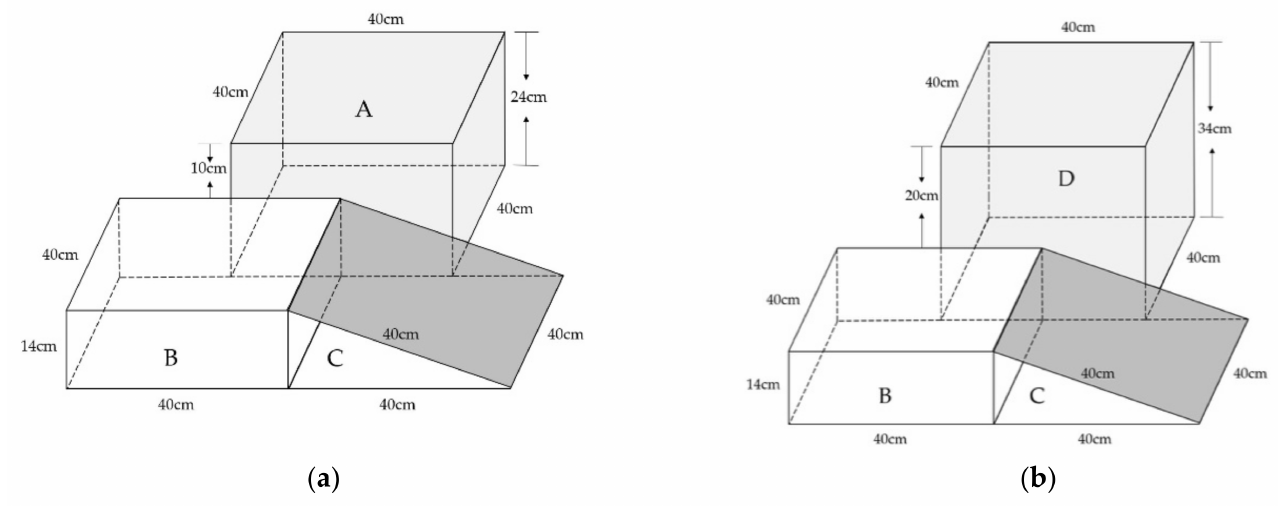
Figure 1. The two different heights of AIDAL: ( a ) 10 cm heights between A and B; ( b ) 20 cm heights between D and